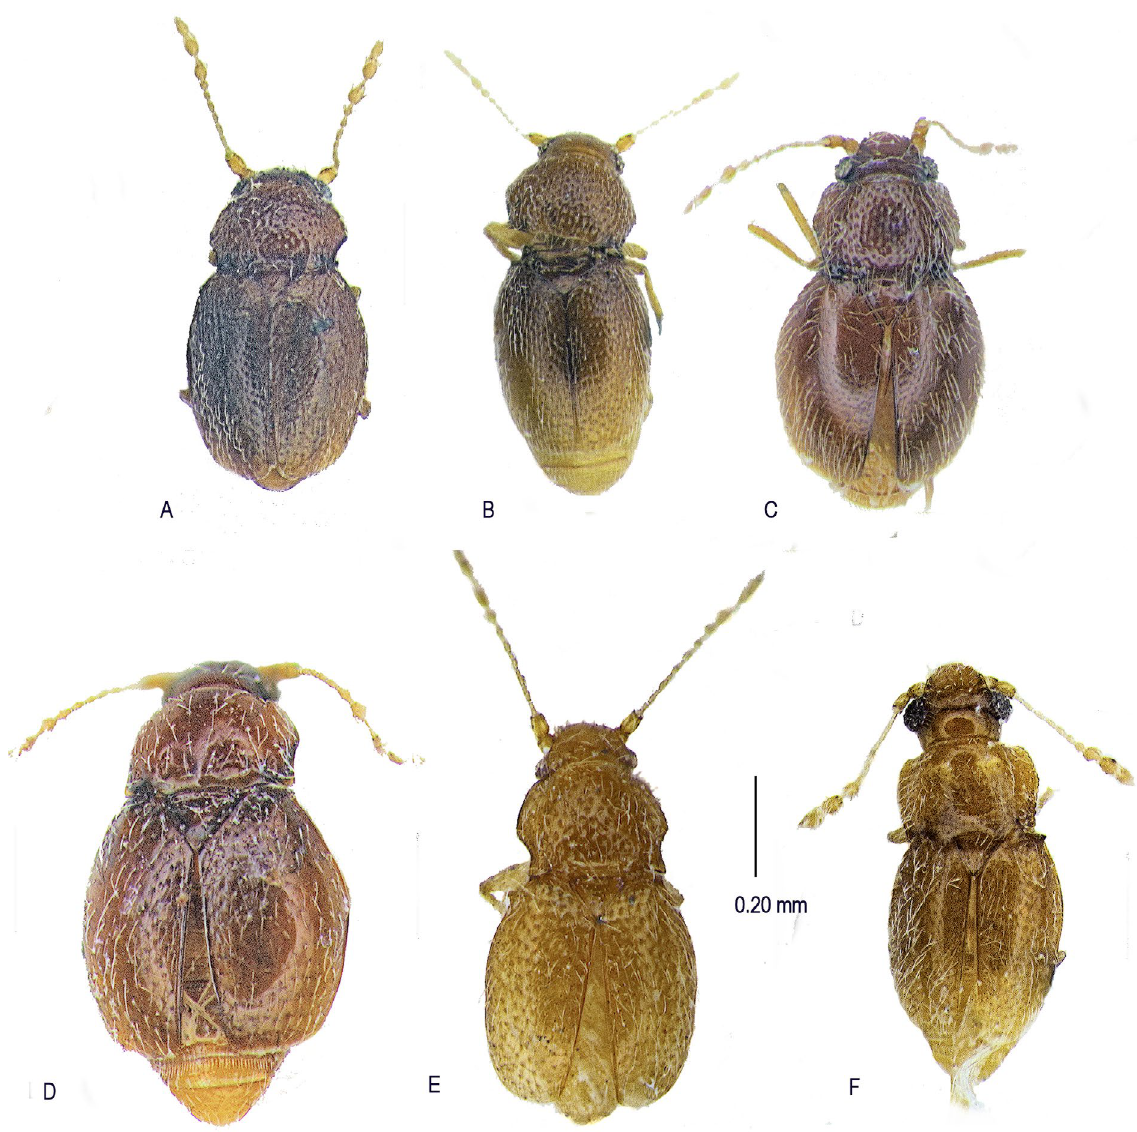
Fig. 6. Cissidium spp., habitus. A . C. marshallae sp. nov. B . C. pauxillum sp. nov. C . C.